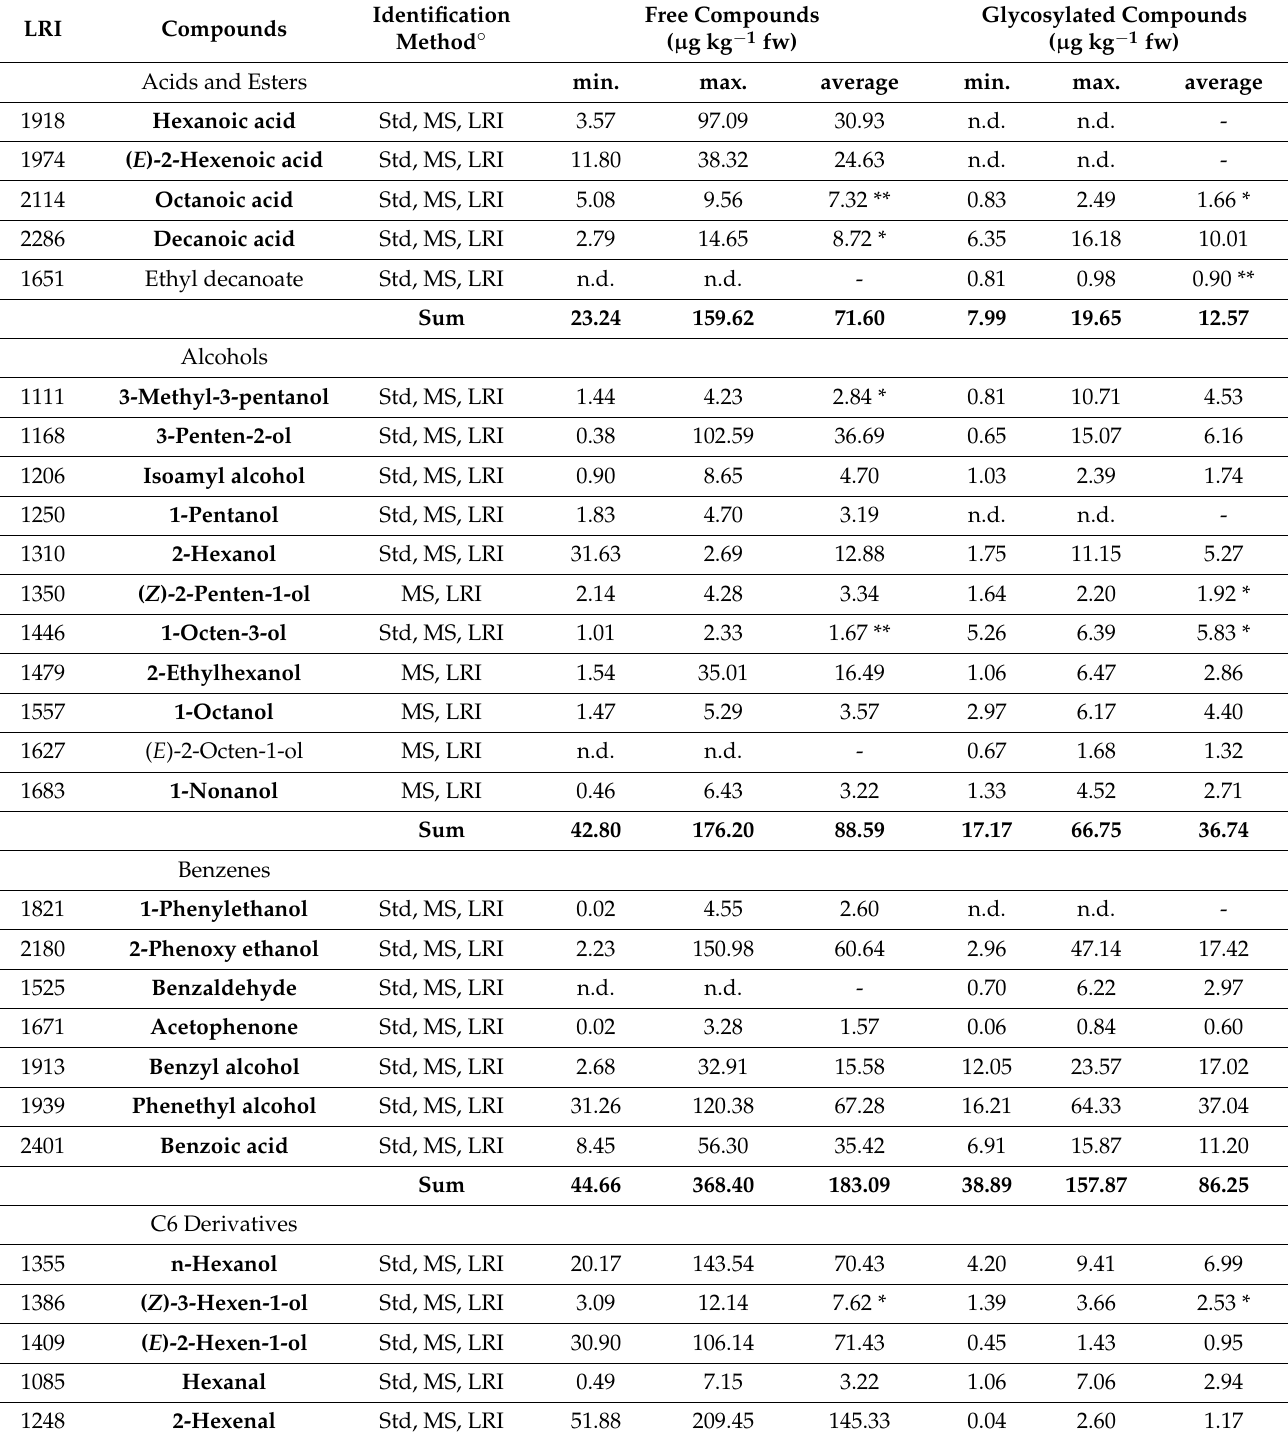
Table 2. Free and glycosylated volatile compounds identified in berries of cv. Trebbiano Romagnolo. For each compound (both free and glycosylated forms), minimum (min.) and maximum (max.) refer to values of all replicates ( n = 12), regardless of treatment and